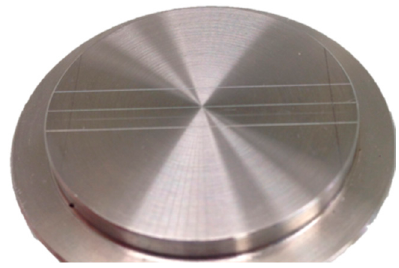
Figure 2. Matrix (International Organization for Standardization (ISO) 4823:2000).